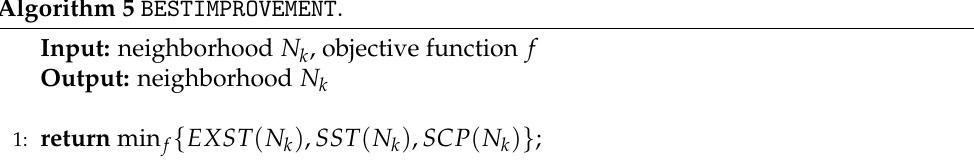
Algorithm 5 BESTIMPROVEMENT .